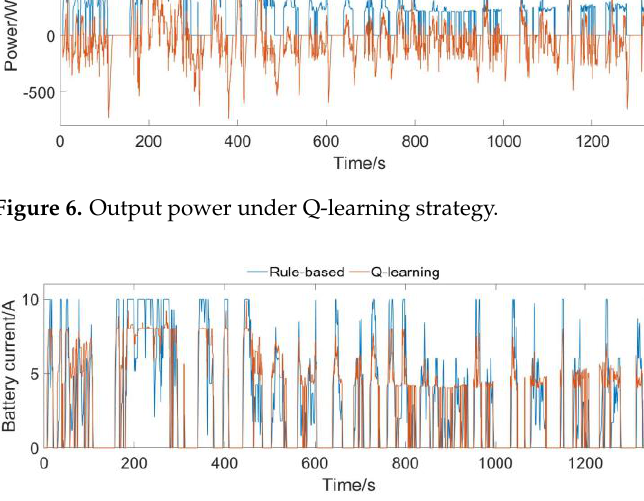
Figure 7. Output current comparison .